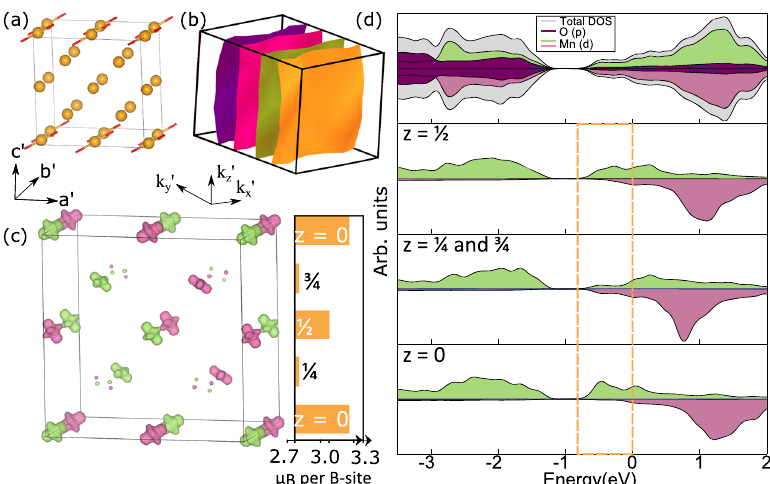
Fig. 4 DFT + U results of the structural relaxation of the OO – CD model for the x = 3 + c a , c' = a - c and b' = b with respect to the experimental setting. Only the Mn B sublattice, with Jahn-Teller long bonds, is shown for clarity. b The Fermi 2 2 2 2 surface consists of sheets perpendicular to k ' y indicative of one-dimensional conductivity. c Magnetic moments in Bohr magnetons ( μ B ) for Mn B by layer and magnetisation density isosurface plots at value of ±0.03 (positive green, negative pink) for energy window 0 to − 0.8 eV below the Fermi level, as indicated in the site- and spin-resolved density of states (DOS) ( d ). Only the projected DOS for the spin-up Mn sites are shown in the various